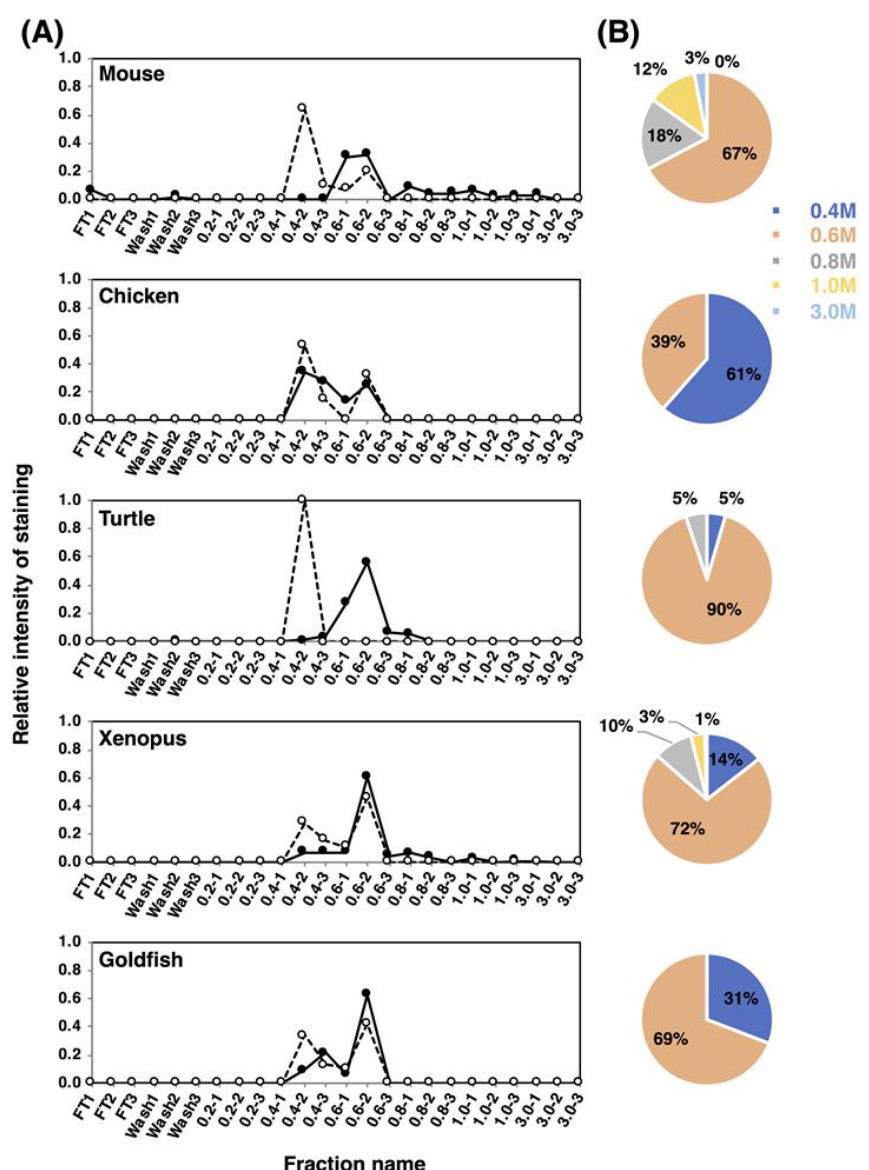
Figure 8. Net negative charge analysis of polySia-NCAM and endo-N-treated NCAM from brain homogenates of five vertebrate brains. Brains from five vertebrates (mouse, chicken, turtle, xenopus and goldfish, n = 1) were analyzed using DEAE-Sephadex A-25 anion-exchange chromatography. ( A ) Elution profiles of polySia-NCAM and endo-N-treated NCAM. Crude samples or endo-N-treated samples (500 μg as protein) were applied to the column, and eluted in a step-wise manner using 1.5 mL of 2 mM Tris-HCl (pH 8.0) buffer containing 0.1% Triton and NaCl (0.2, 0.4, 0.6, 0.8, 1.0, and 3.0 M). Then, 10 μL of the sample from each fraction was analyzed by SDS-PAGE/Western blotting. Crude samples were analyzed for the majority of the polySia on NCAM using the anti-polySia antibody 12E3 (solid line), while the Endo-N-treated samples, i.e., oligoSia-NCAM, were analyzed using the anti-NCAM antibody (broken line). Flow-through (FT) and wash fractions comprised only 0.1% Triton and 2 mM Tris-HCl (pH 8.0) with 0.15 M NaCl. The sum of all fraction intensities detected by Western blotting was set to 1.0. ( B ) Pie charts of the distribution of negative charges represented as NaCl concentration for each animal. Based on the chromatograms (left panels) of the crude sample, the intensity of 12E3 staining from each of the indicated NaCl concentrations was summed, and expressed as its proportions (%) to the summation of the intensities for all NaCl concentrations used. Blue, pink, grey, yellow, and sky blue represent 0.4 M, 0.6 M, 0.8 M, 1.0 M, and 3.0 M, respectively.